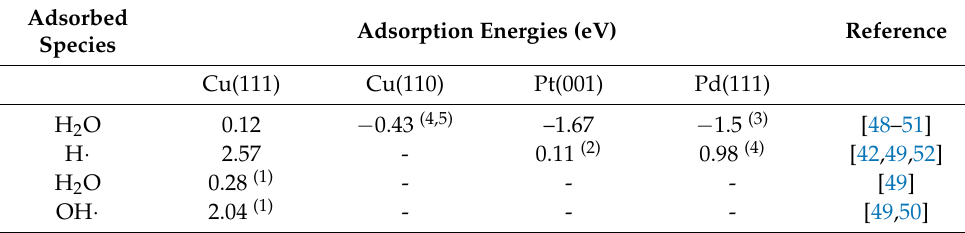
Table 1. Adsorption energies of H, H 2 O, and OH species onto Cu(111), Pt, and Pd